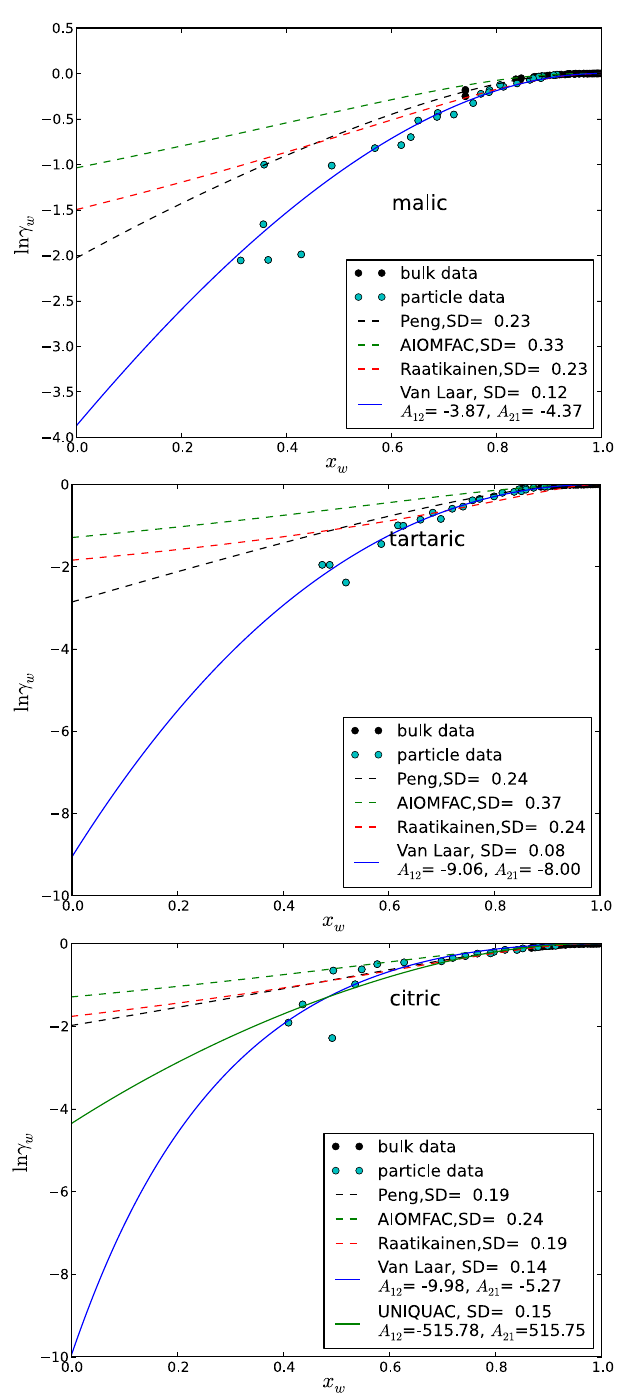
Fig. 2. Logarithm of water activity coefficient at 25 ◦ C in function of mole fraction water, for malic, tartaric and citric acids. Particle experimental data is from Peng et al. (2001), bulk experimental data is from several sources (see Appendix A). Fitted activity coefficient expressions (Van Laar, UNIQUAC) are also included, as well as es- timations by UNIFAC-Peng, AIOMFAC and UNIFAC-Raatikainen. The standard deviation vs. the experimental data is also